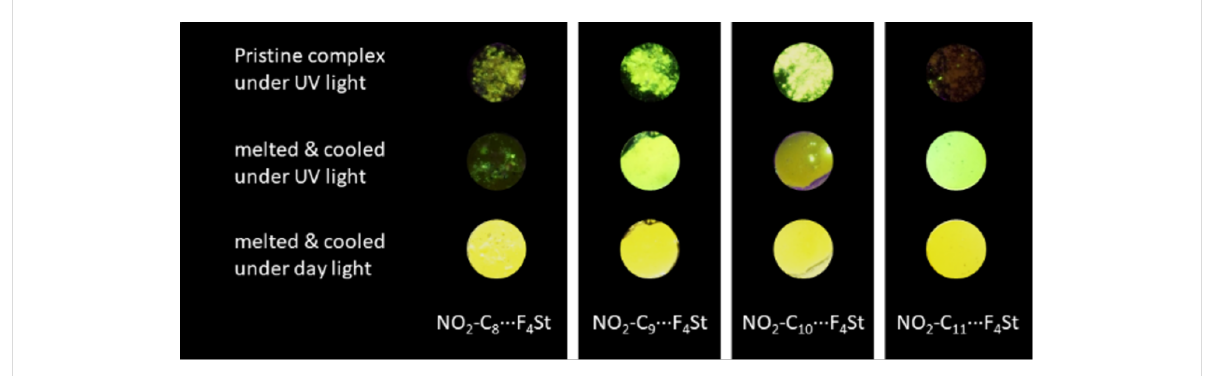
Figure 8: Photographs of the assemblies with different alkoxy chain lengths on the NO 2 -C n moiety directly after the removal of the solvent (pristine) and after one heating/cooling cycle reveal the impact of the alkoxy chain length and a significant rearrangement of the solid-state packing upon heating/cooling the sample (diameter of sample ≈ 0.8 cm).